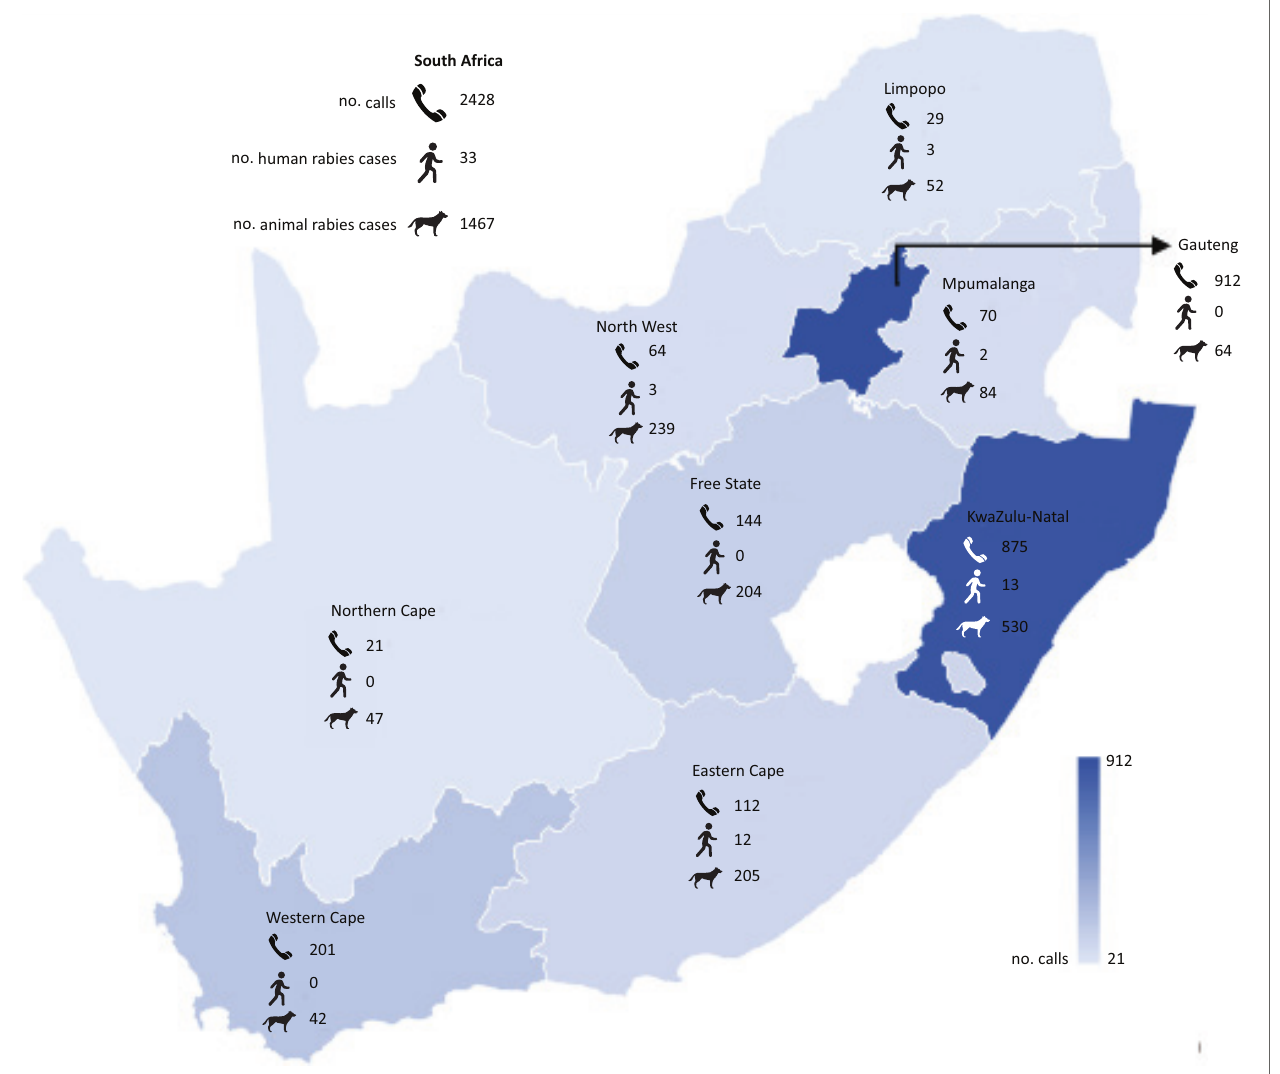
FIGURE 4: Provincial distribution of calls received, confirmed human 26 and animal 6 rabies cases from 01 January 2016 to 31 December